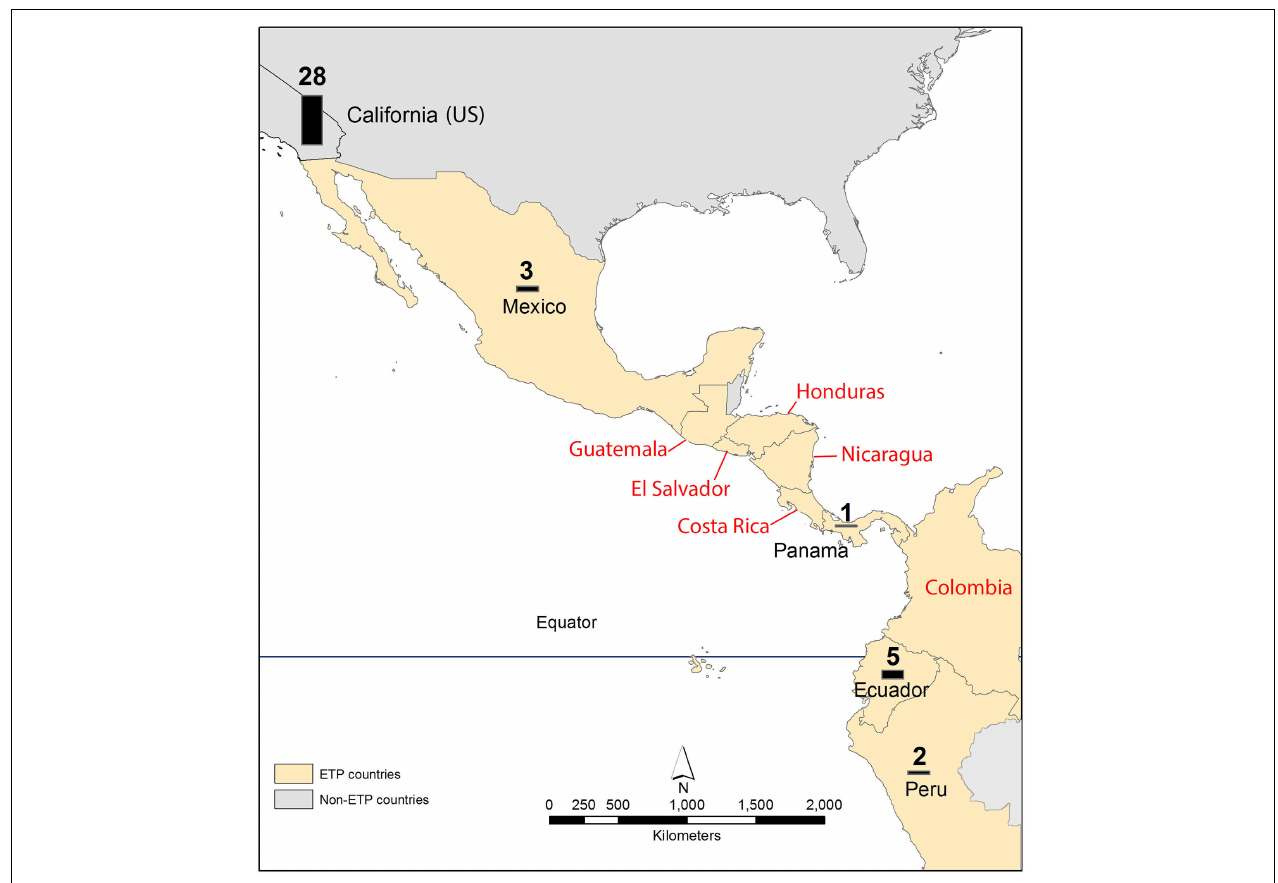
FIGURE 2 | The number of historical vessel strike records in the IWC’S Global Ship Strike Database (International Whaling Commission (IWC), 2010) in California (United States) and from the 10 ETP countries. The number above the name represents the number of vessel strike records from that location (countries (red) with no number had no historical vessel strike